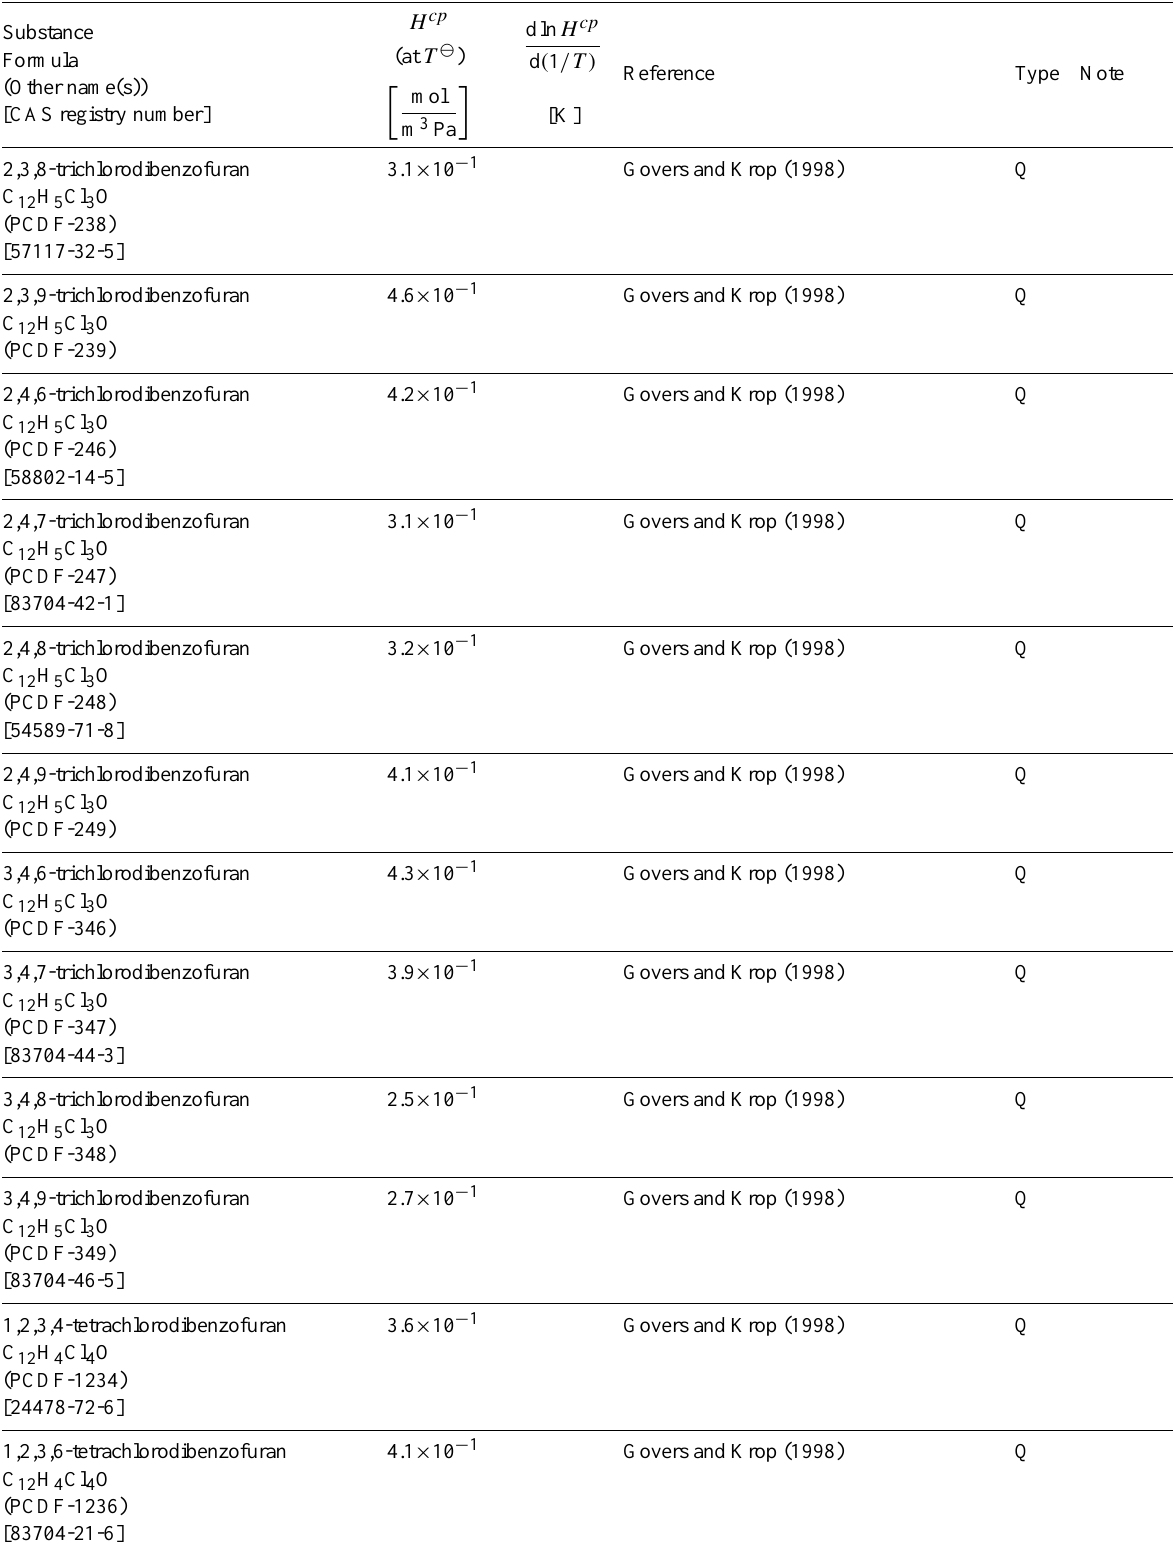
Table 6: Henry’s law constants for water as solvent